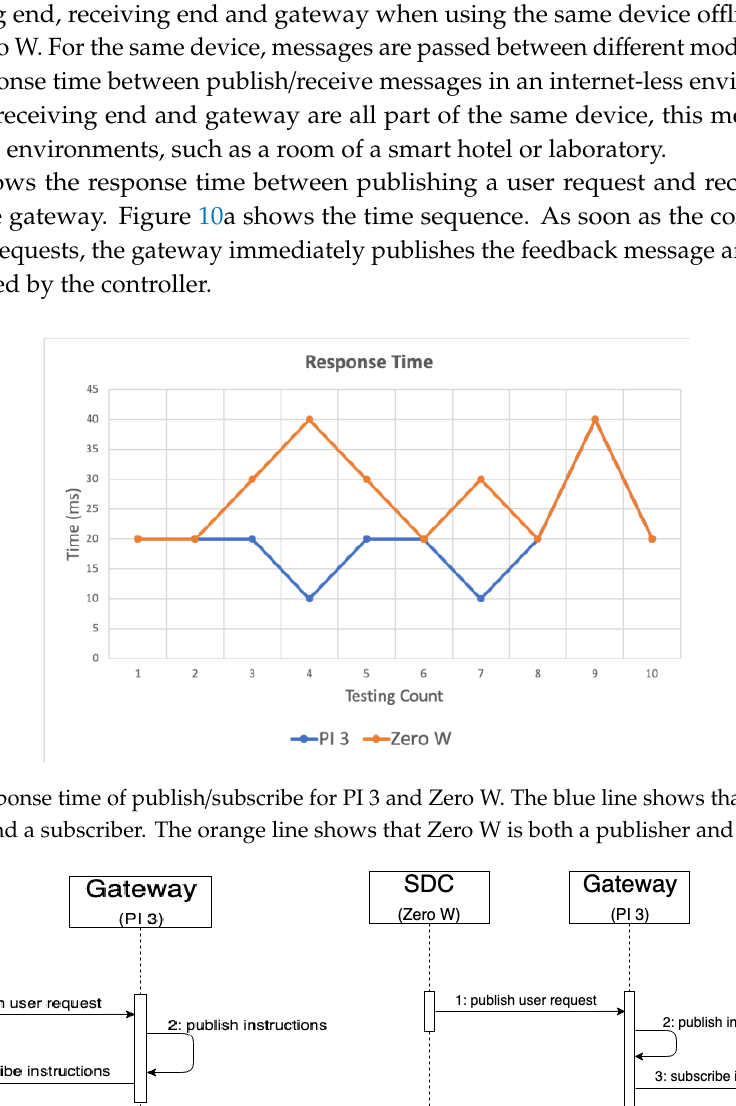
Figure 11. Response time of publish/subscribe between different devices. Pi 3 publishes a message as a publisher; then, Zero W subscribes a message as a subscriber. 4.3. Logical Control Through Gateway In this experiment, the sender publishes the instruction message after the logic control of the gateway, and the SDC receives the message. The purpose is to analyse the response time, which is controlled by the logic control. In the experiment, the logic control of Algorithm 2 was used by Python, and Pi 3 was used as the gateway. After receiving the General Purpose Input/Output (GPIO) message, the algorithm reads the status of the device to be controlled and determines the button function corresponding to the GPIO. In this experiment, the button was pressed 10 times. The corresponding button functions are pressed to turn the device on or off. After the message is published, the gateway performs the logic control of the device to generate the device instructions. Finally, the instruction message is published. Figure 12 shows the execution time, which is an average of 1822.298 ms.